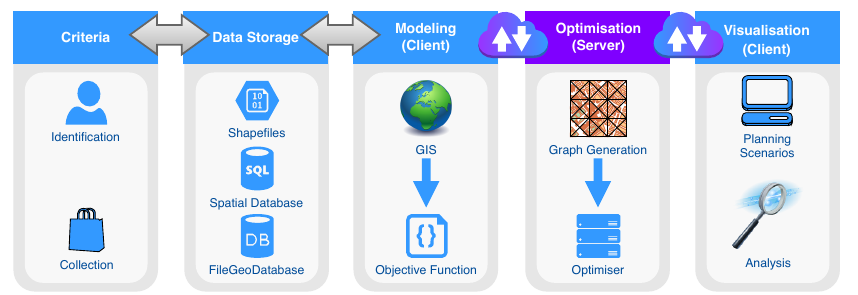
Figure 1. Overview of the presented workflow: After a set of suitable criteria for a planned grid expansion is identified by start and end point, the modelling of the study area and optimisation criteria is performed by the implemented ArcMap add-in (client). Processed data is transferred to the optimisation server by means of a RESTful web service. A discrete structure (grid graph) is derived from preprocessed spatial data and the optimisation process is started. After an approximation of the Pareto-front (a set of suitable paths) is calculated, results are transferred back to the client for analysis.